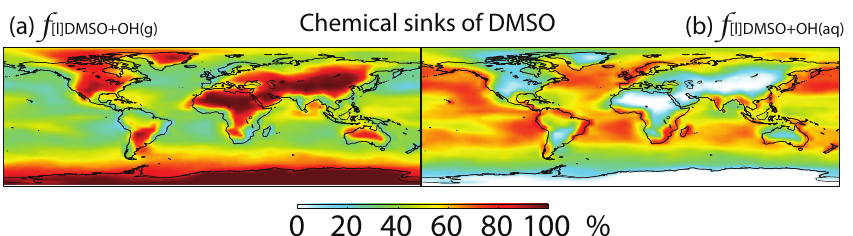
Figure 5. Global tropospheric distribution of annual-mean percentage of DMSO oxidized via (a) DMSO + OH ( g ) ( f [ l ] DMSO + OH (b) DMSO + OH ( aq ) ( f [ l ] DMSO + OH